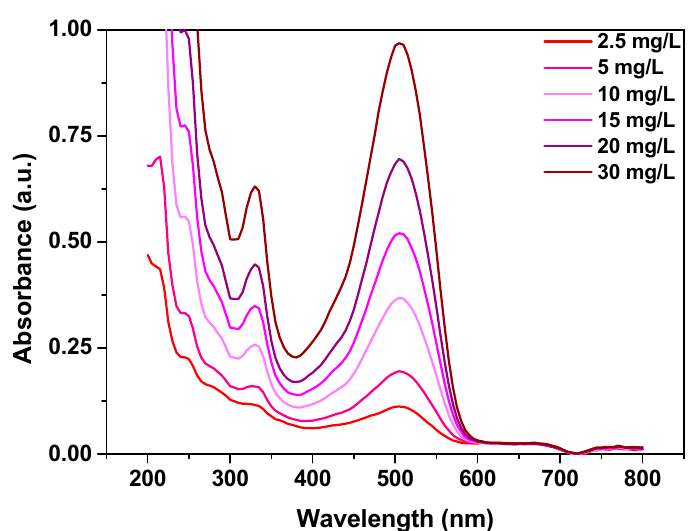
Figure 1. Spectra of AR18 at different concentrations.